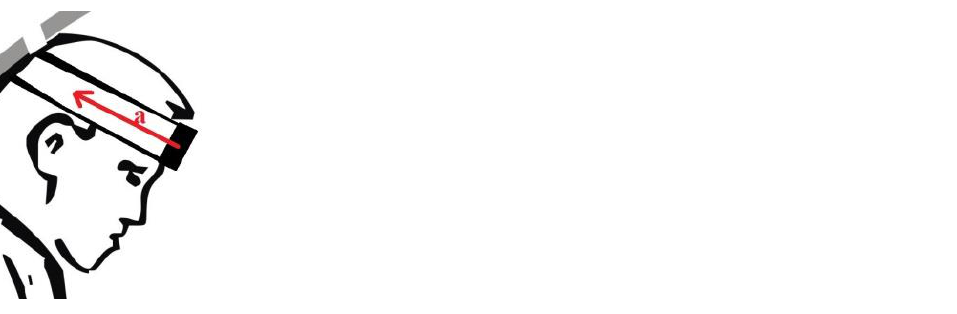
Figure 3. The Wiva ® Science motion sensor mounted to the head to measure acceleration, “a”. The sense of the vector “a” presented in the figures corresponds to its positive values; the opposite direction would correspond to negative values, mainly obtained in group B.